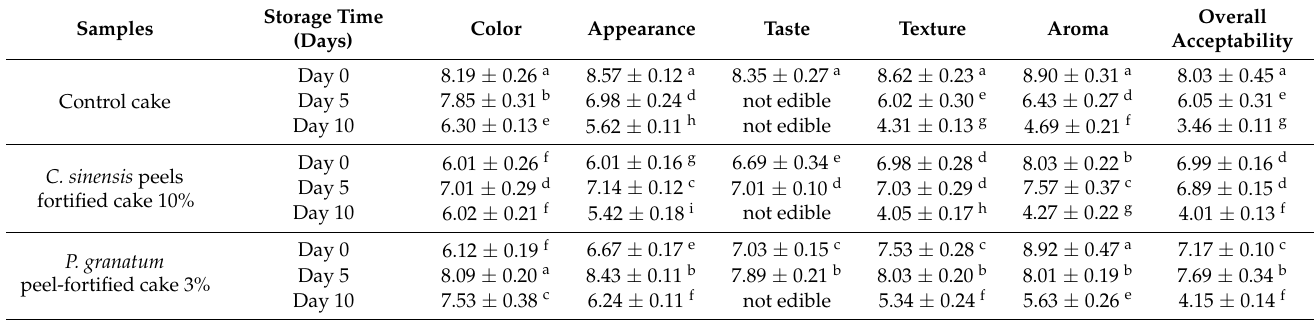
Table 12. Effect of shelf life on sensory evaluation for cake supplemented with C. sinensis and P. granatum peel powder at room temperature (30 ◦ C).